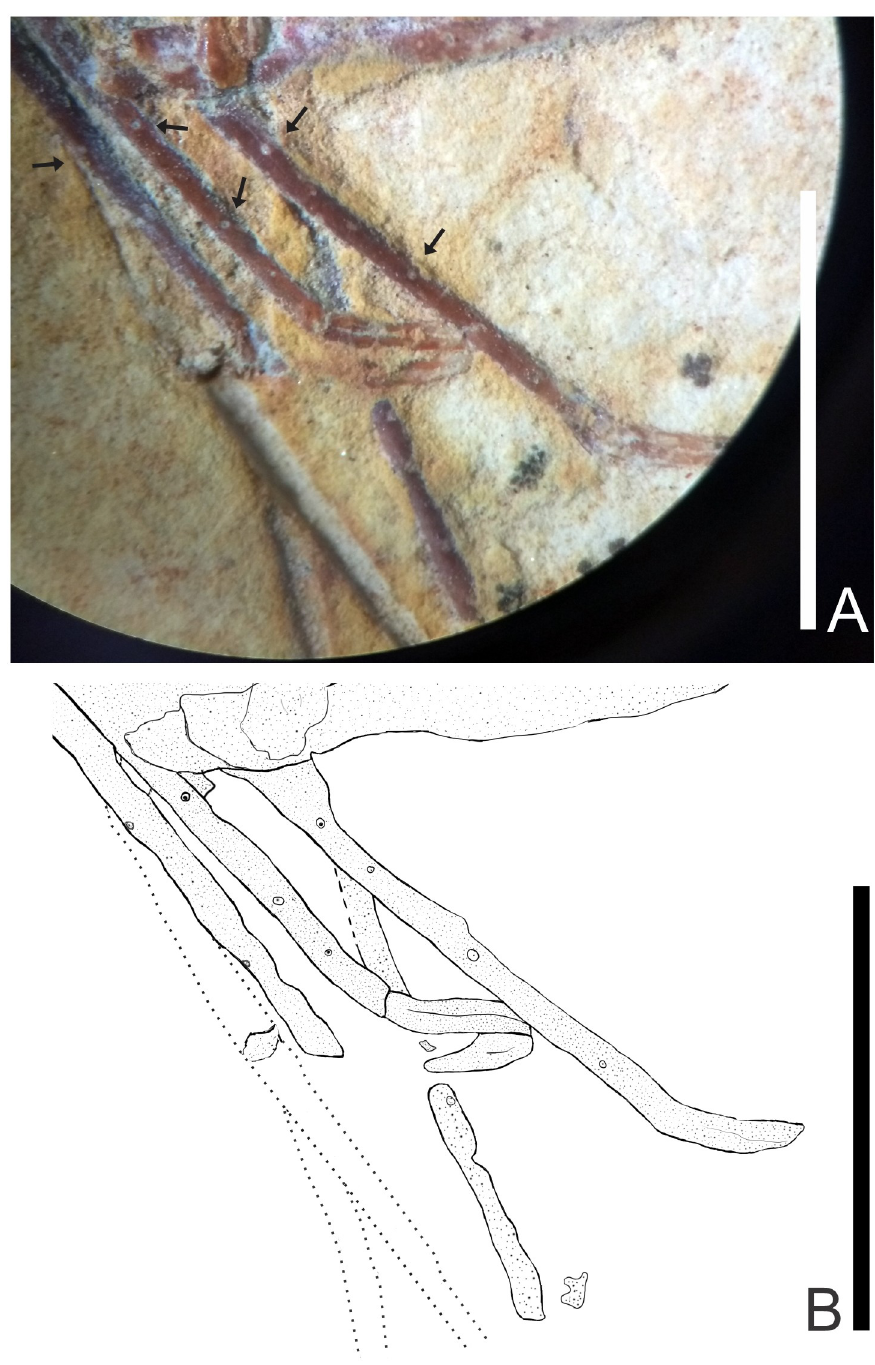
Fig 16. UFRJ 243/CR. A) Pereiopods 3–5 have several tubercles in the merus and carpus. B) Reconstitution, dotted lines represent appendages not preserved but with impressions on the matrix. Scale bars: 5 mm. Photo and drawing by Olga A.